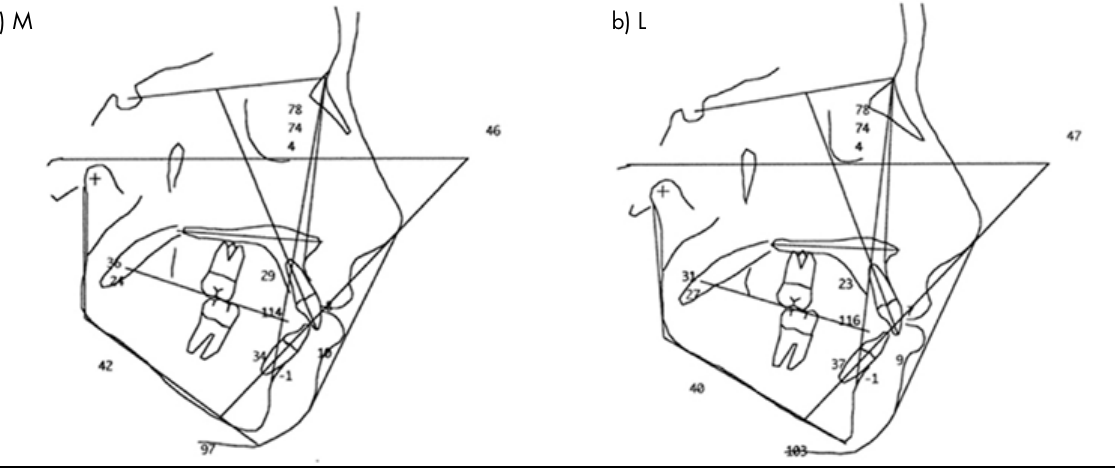
Figure 14. Post-treatment cephalometric tracings at T2.